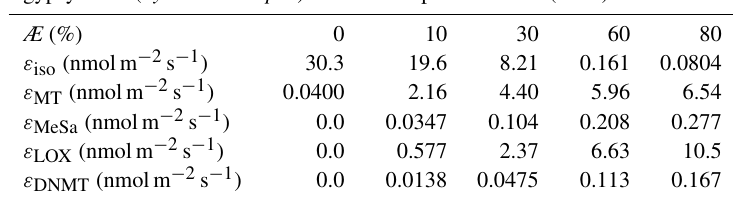
Table A1. Emission factors ( ε i, Æ , in nmolm − 2 one-sided LAIs − 1 ) at a few different degrees of stress ( Æ ). ISO stands for isoprene, MT stands for monoterpenes, MeSa stands for methyl salicylate, LOX stands for lipoxygenase pathway volatile compounds, DMNT stands for 4,8-dimethyl-1,3,7-nonatriene, MeOH stands for methanol, SQT stands for sesquiterpenes, and α -Eud stands for α